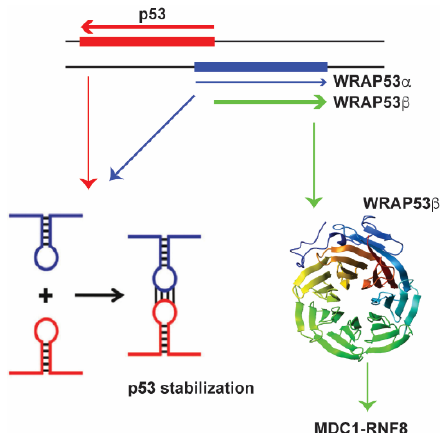
Figure 1. The antisense lncRNA WRAP53 α (shown in blue) directly interacts with the p53 mRNA (shown in red) to stabilize it, affecting p53 protein levels. The WRAP53 β (in green) recruits and stabilizes RNF8 at double strand breaks.